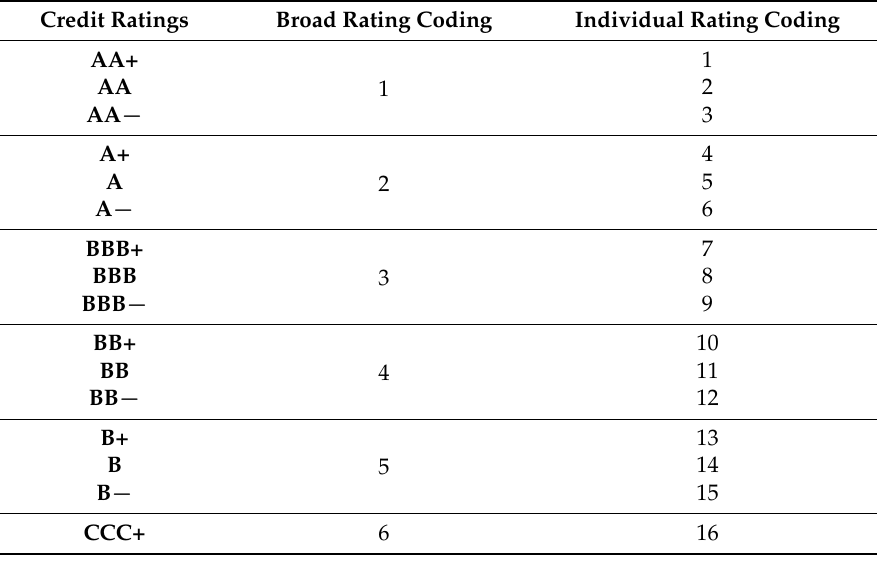
Table 1. Long-term issuer credit ratings and assigned numerical